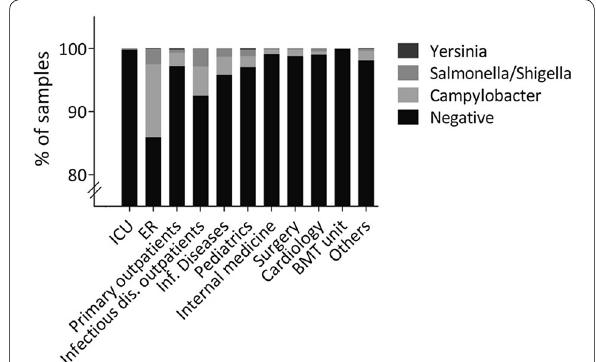
Fig. 2 Results of all stool cultures taken during 2010–2015 at the University Center in Hamburg-Eppendorf according to patients’ site where the stool sample was taken; depicted as % of all analyzed specimens; specimens taken per week: 1–5 (surgery), 5–10